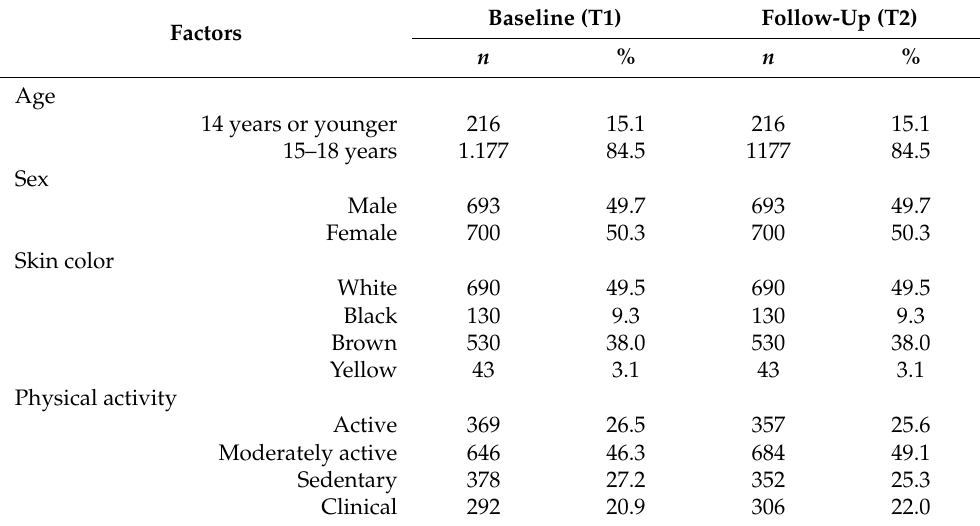
Figure 1. Flow chart of study participants (TSP, thoracic spine pain). Table 2. Descriptive statistics of the study groups at baseline and at one-year